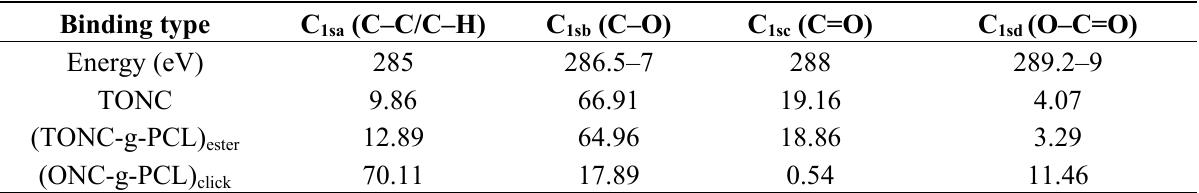
Table 2. Experimental atomic composition and oxygen to carbon (O/C) ratio obtained by XPS analysis for TONC, (TONC-g-PCL)